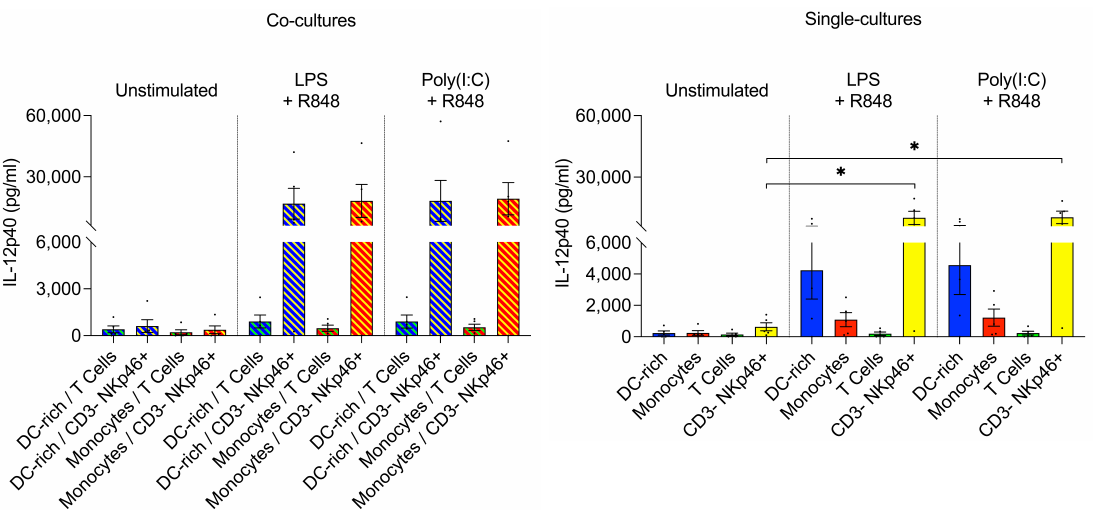
Figure 3. IL-12p40 concentrations in the supernatants of porcine monocytes and DC-enriched PBMCs co-cultured with T cells and CD3– NKp46+ cells ( left ), as well as in isolation ( right ). All were following 24 h stimulation with LPS (100 ng/mL) or poly(I:C) (500 ng/mL) and R848 (300 ng/mL). All cell types were stimulated in parallel from each pig, with a total of n = 5 pigs. Co-cultures were performed with a ratio of 1 monocyte/DC to 3 T cells/CD3– NKp46+ cells. Asterisks indicate statistical significance; paired t test; * p ≤